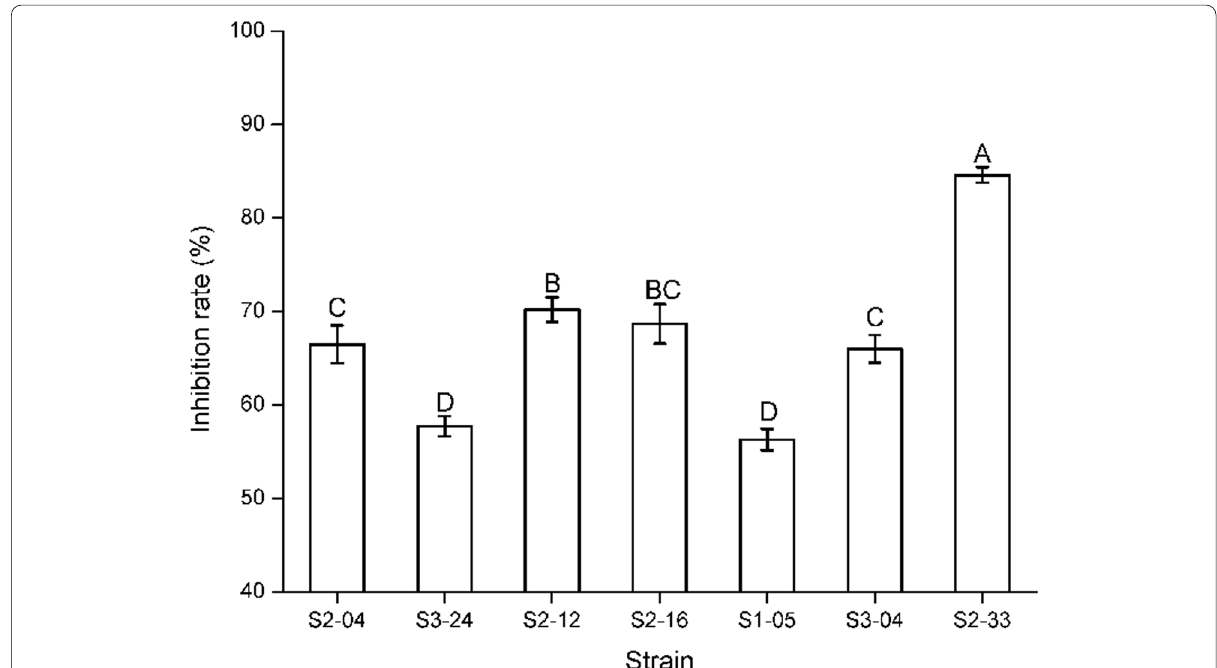
Fig. 2 Inhibition rate of seven strains against Rhizoctonia cerealis (Kruskal-Wallis test: H different letters indicates significant differences ( α